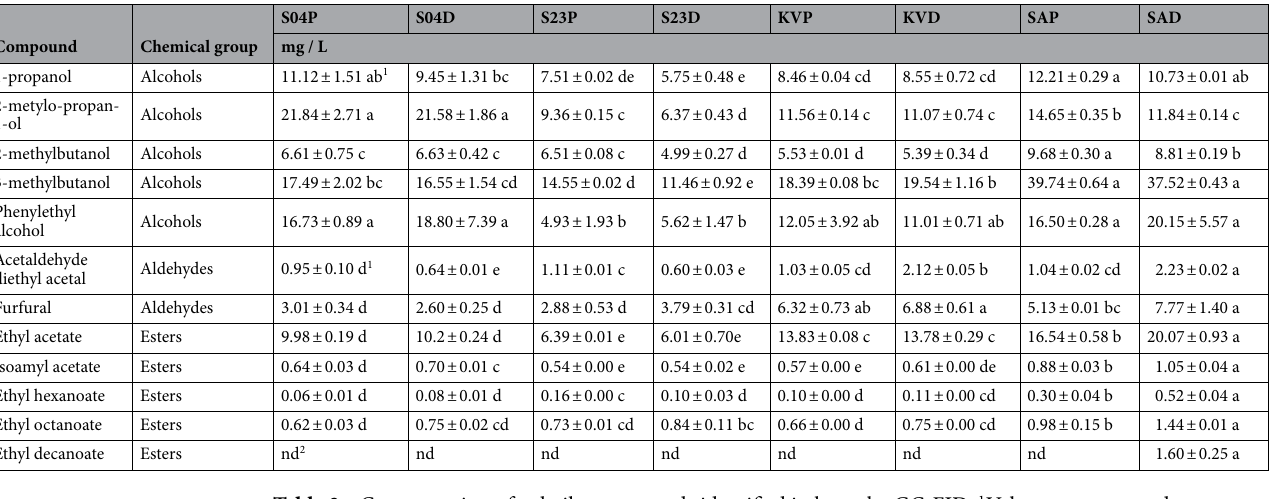
Table 2. Concentration of volatile compounds identified in beers by GC-FID. 1 Values are expressed as mean (n = 2) ± standard deviation. The mean values with different letters (a, b, c, d, e, f) within the same row are statistically different ( P < 0.05). 2 nd -not